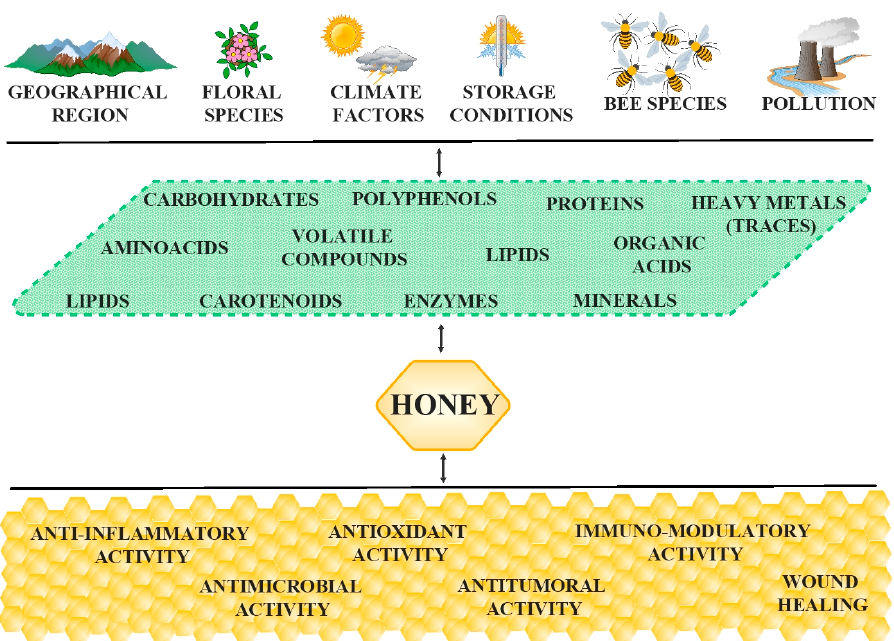
Figure 1. Interdependence of honey composition and biological activity by different factors. The figure was designed with ConceptDraw Diagram 16.